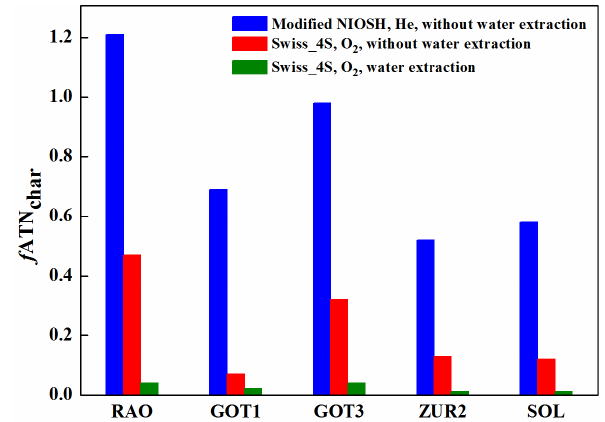
Fig. 3. Fig. 3. Fraction of charred OC related to total EC ( f ATN analysis using different methods for five typical